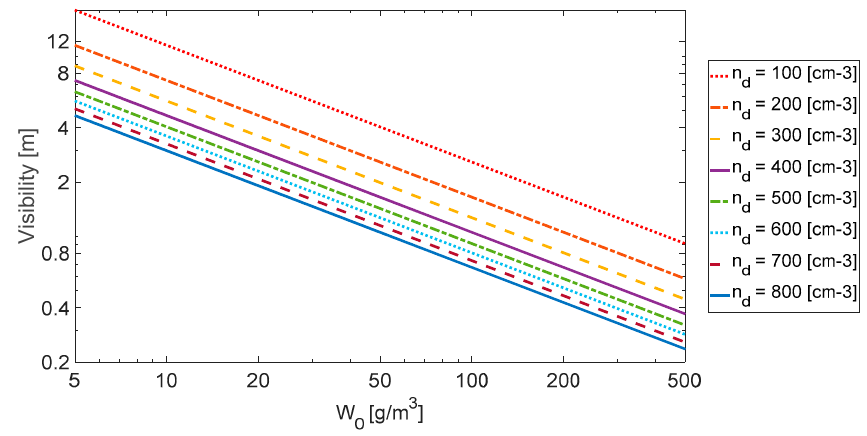
W (g/m 3 ) on assumed droplet number 0